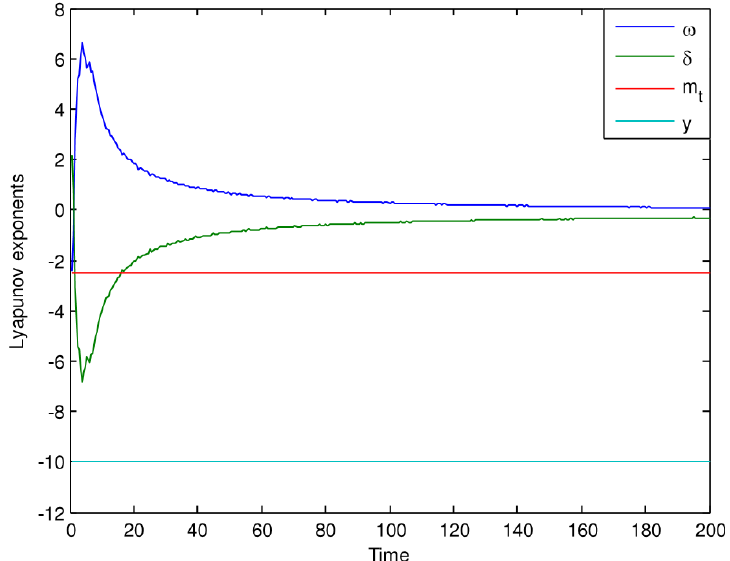
Figure 1. Phase diagrams of the system with increase initial value of 𝛿 1 (𝑡 0 ) ( a ) 𝑡 ∈ [0, 350] and ( b ) 𝑡 ∈ [350, 500].